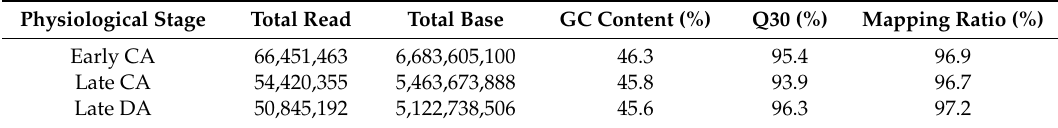
Average read length was 101 bp. Each value is the mean of three biological Table 1. Transcriptome sequencing data statistics from the ‘Soomee’ peach tree shoots during cold acclimation (CA), from early to late CA, and deacclimation (DA), from late CA to late DA. GC Physiological Stage Total Read Total Base